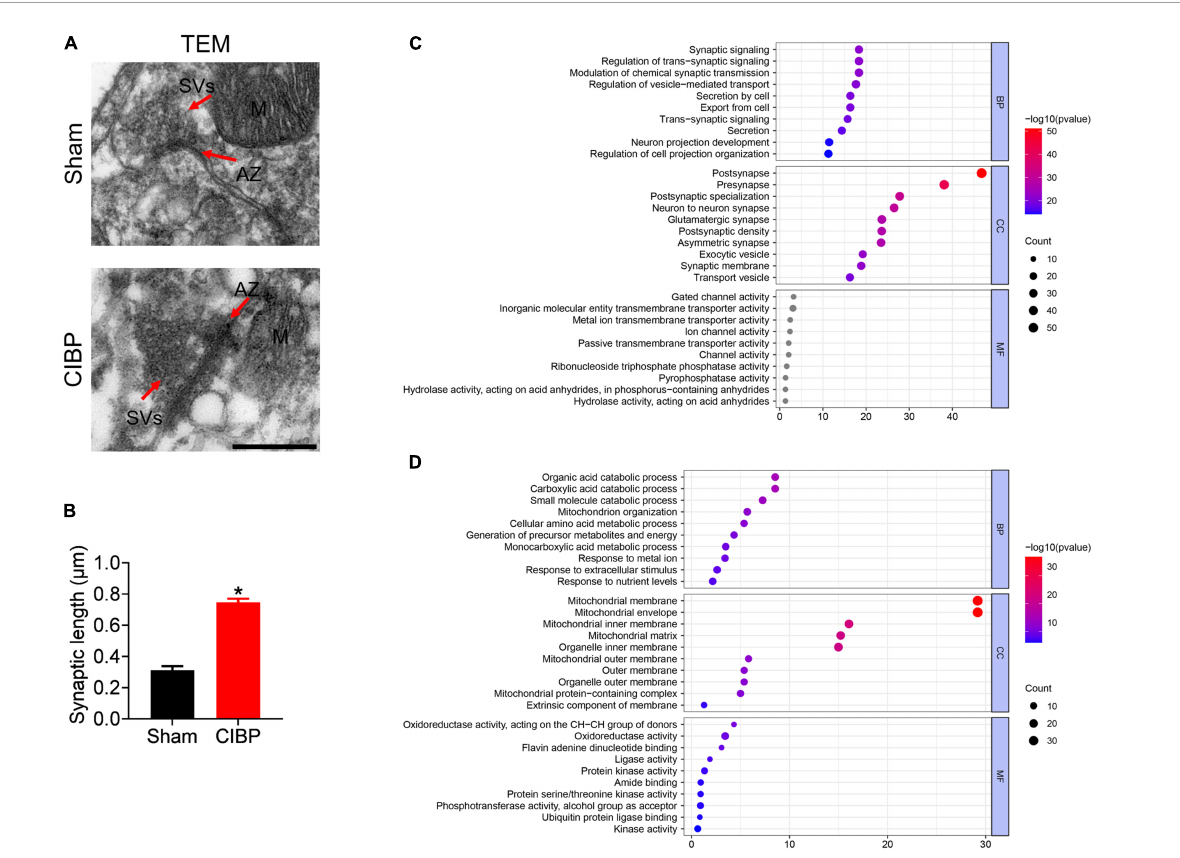
FIGURE4 Changes in synaptic proteins and morphology. (A) Morphological changes in the spinal cord using transmission electron microscopy (TEM). AZ: active zone; SVs: synapse vehicles; M: mitochondria. Scale bar: 500 nm. (B) Relative synaptic length of sham and CIBP group. Data were expressed as the mean ± SD ( n = 3 mice/group). * p < 0.05 vs. sham group. (C,D) Synaptic (C) and mitochondrial (D) proteins were classified by GO terms based on BP, CC, and MF. The color of the bar denoted –log10 ( p